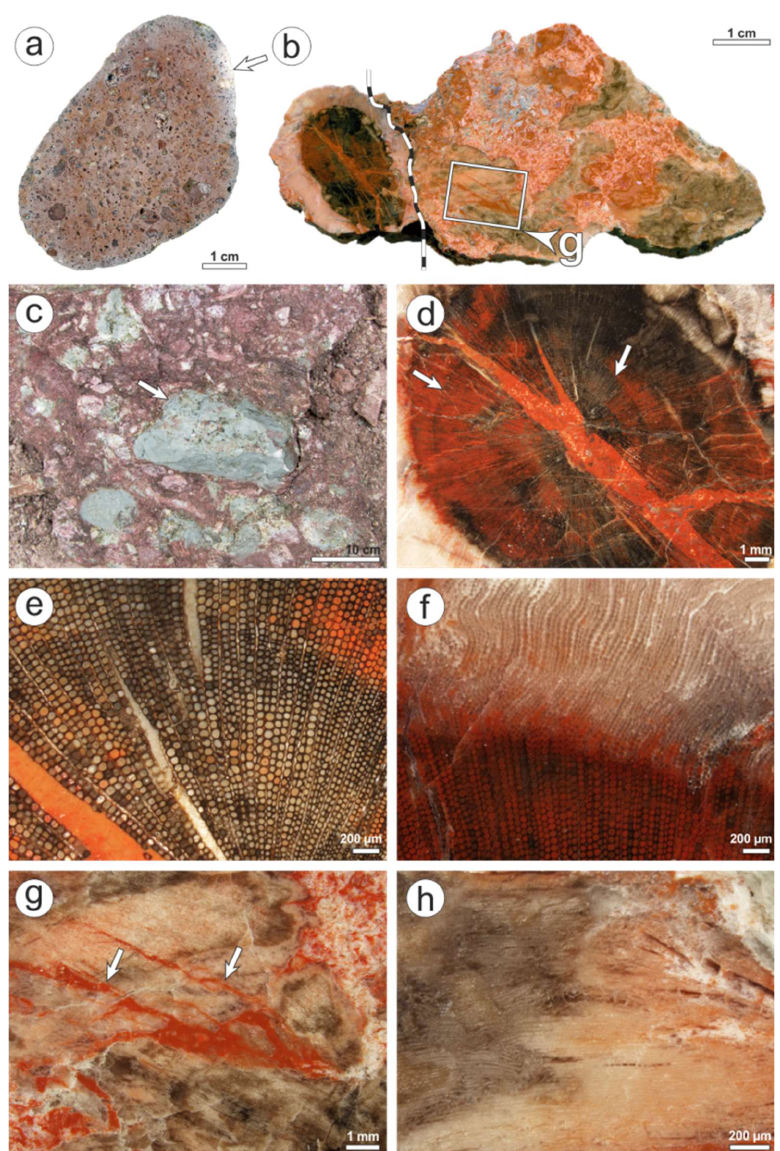
Figure 8. Features of K6556 and its host rock from Winnweiler. ( a ) Rhyolite clast from alluvial debrites of the Donnersberg Fm. Note roundness and bleaching (arrow). ( b ) K6556. The dotted white line marks the interface of the root cross-cut (left) and the surrounding matrix containing wood fragments (right). ( c ) Typical debrite of the middle Donnersberg Fm. Note crucial features of alluvial mass flows: missing sorting and bedding, and polymict composition with lithics (here green tuffs; arrow). ( d ) Close-up of the inner root in cross-section showing growth zonation. ( e ) Round-shaped tracheid cross-cuts. ( f ) Border of well-preserved inner root (below) and poor-preserved outer root rim (above). ( g ) Close-up of wood fragments surrounding the root. Note the jigsaw-like match of neighboring fragments (white arrows). ( h ) Frayed wood in the matrix surrounding the root.